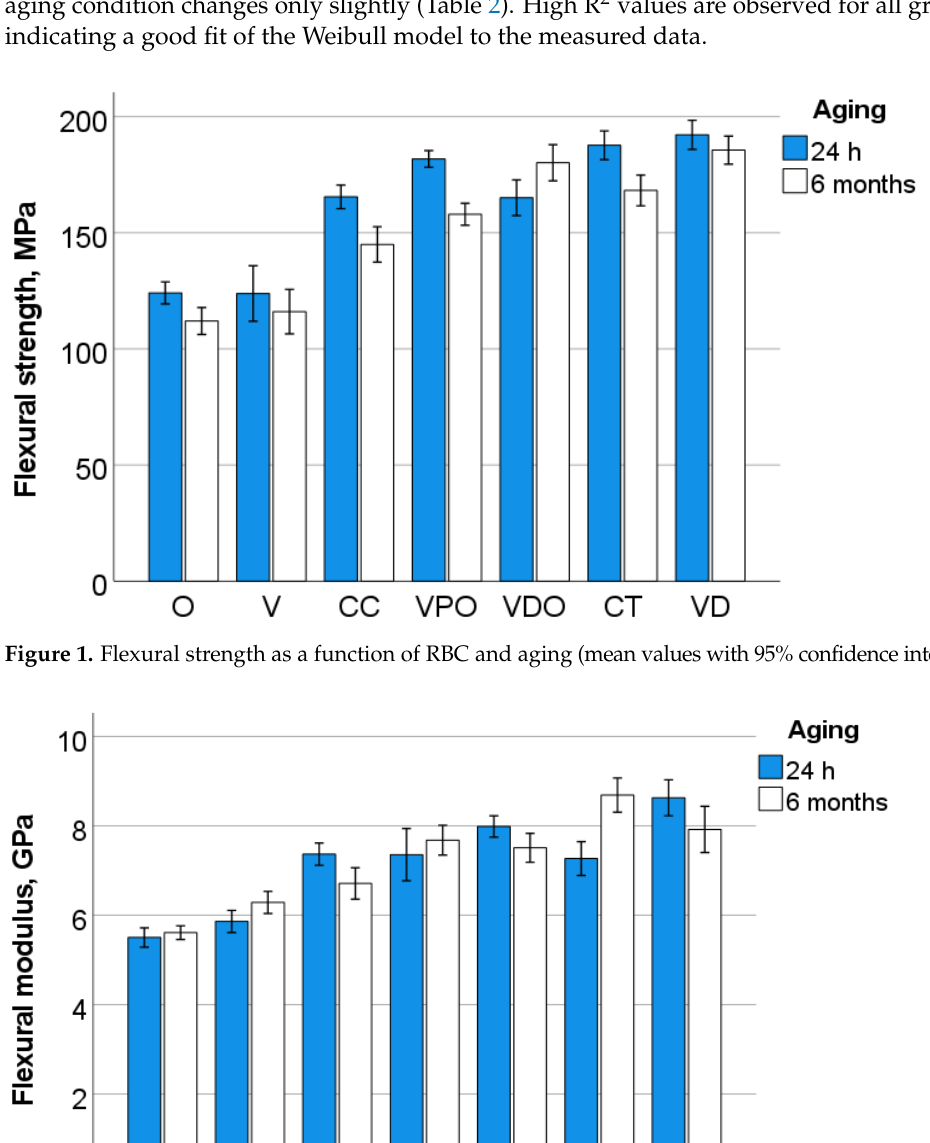
Figure 2. Flexural modulus as a function of RBC and aging (mean values with 95% confidence in- terval).